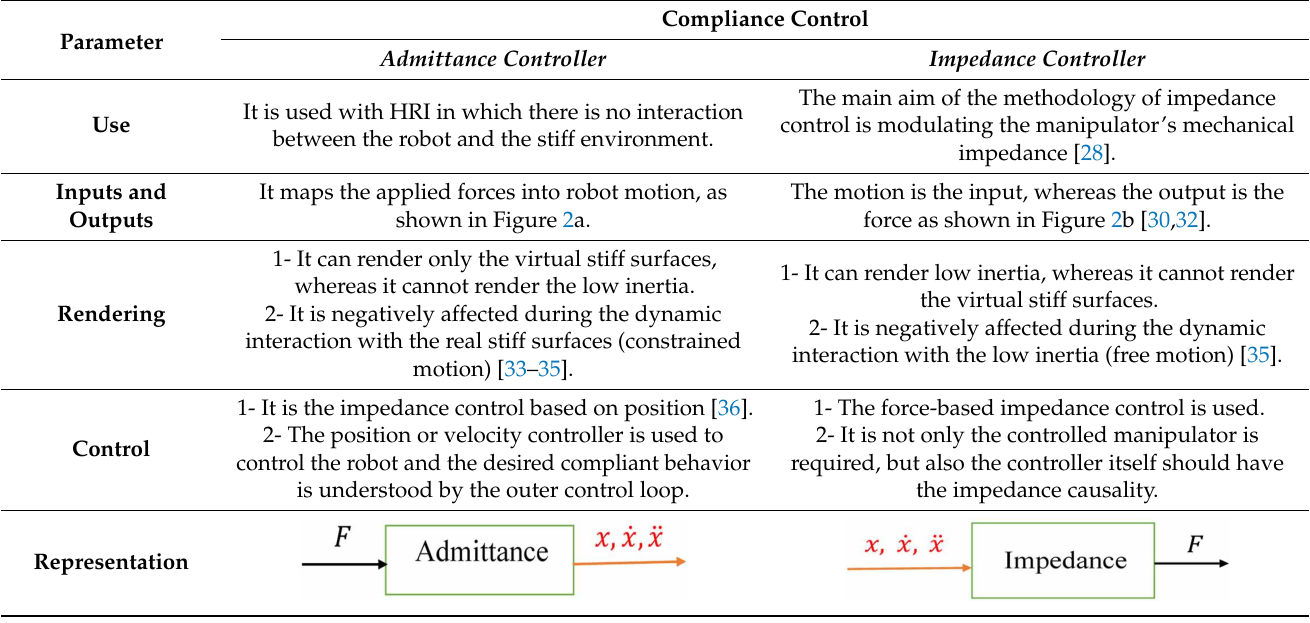
Table 1. Comparison between admittance controller and impedance controller of the robot.